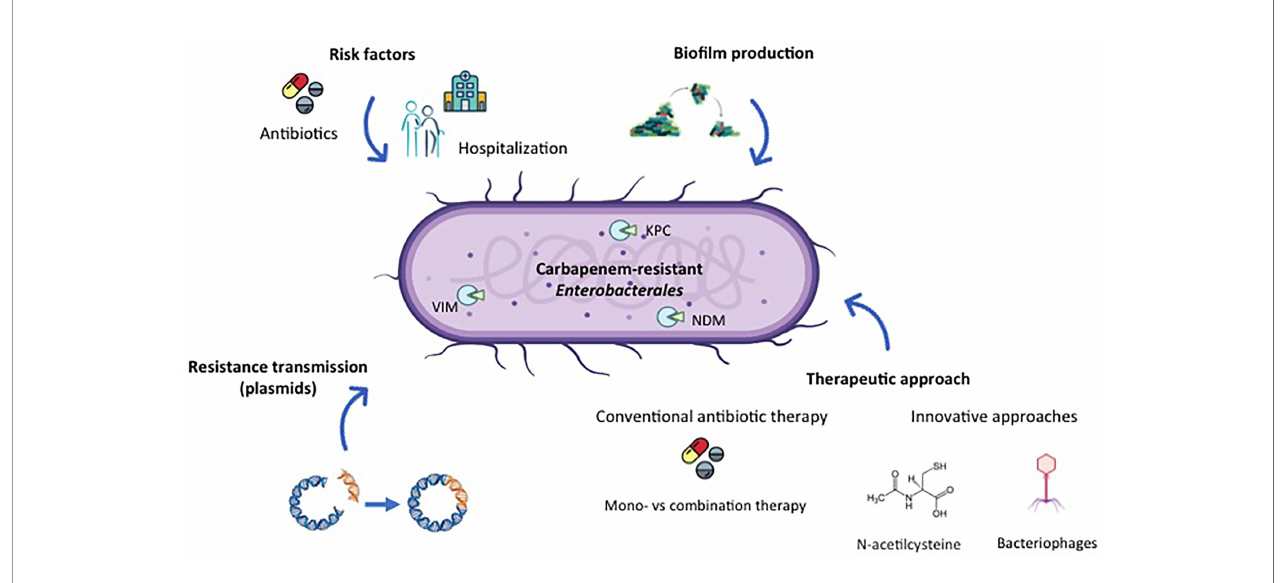
FIGURE 1 | Overview of different features of Carbapenem-Resistant Enterobacterales (CRE)